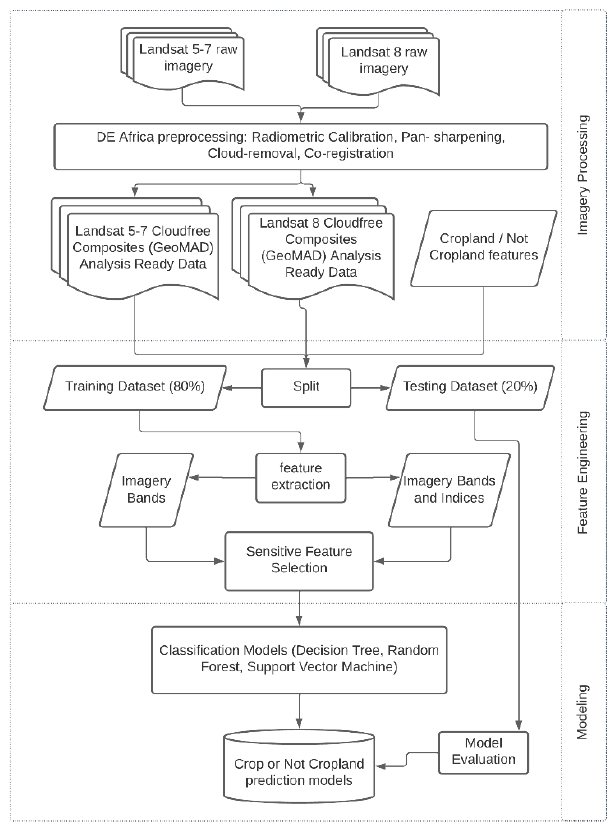
Figure 3. Overall workflow for the